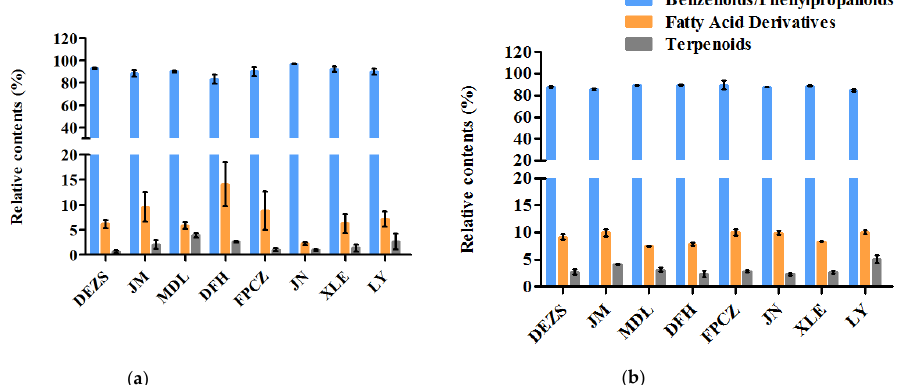
Figure 2. The relative contents of various aroma substances in P. mume cultivars with four aroma types: ( a ) headspace volatiles; ( b ) endogenous extracts.